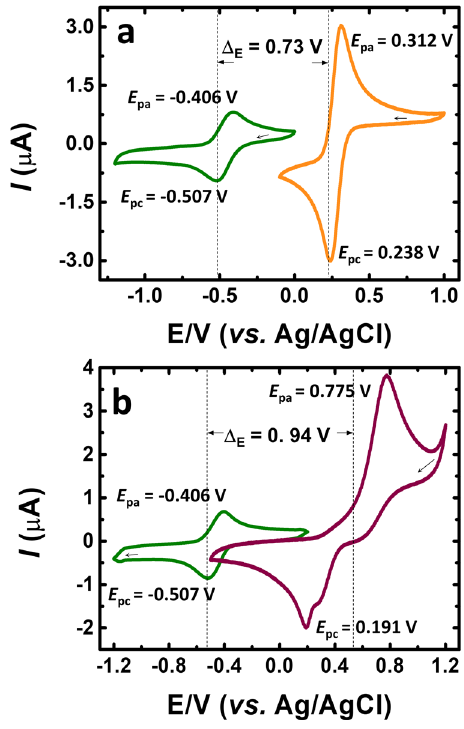
Fig. 2 Cyclic voltammetry. Cyclic voltammograms obtained with saturated N 2 at υ = 50 mV s − 1 in 1.0 M KCl solution of electrolyte. a 1.0 mM TRYP-SO 3 H (green trace) and 1.0 mM K 4 [Fe(CN) 6 ]·3H 2 O (orange trace). b 1.0 mM TRYSO 3 H (green trace) and 1.0 mM BQDS (purple